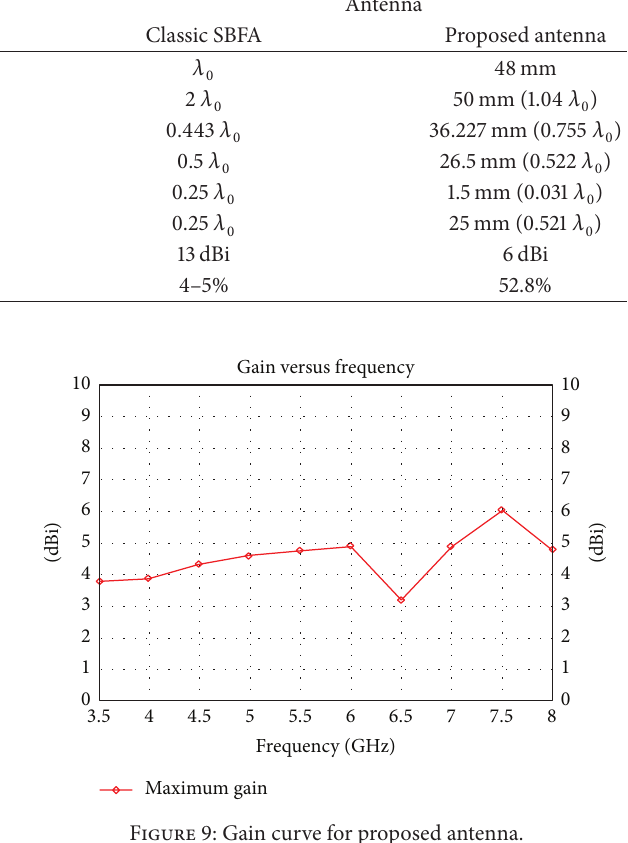
Figure 8: Directivity versus frequency curve for proposed antenna.